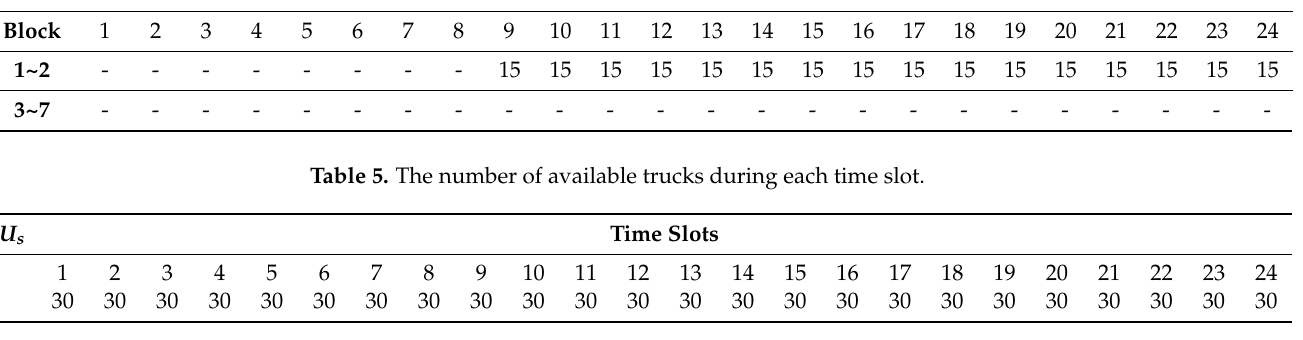
Table 6. The appointment quota for each yard block during each time slot.